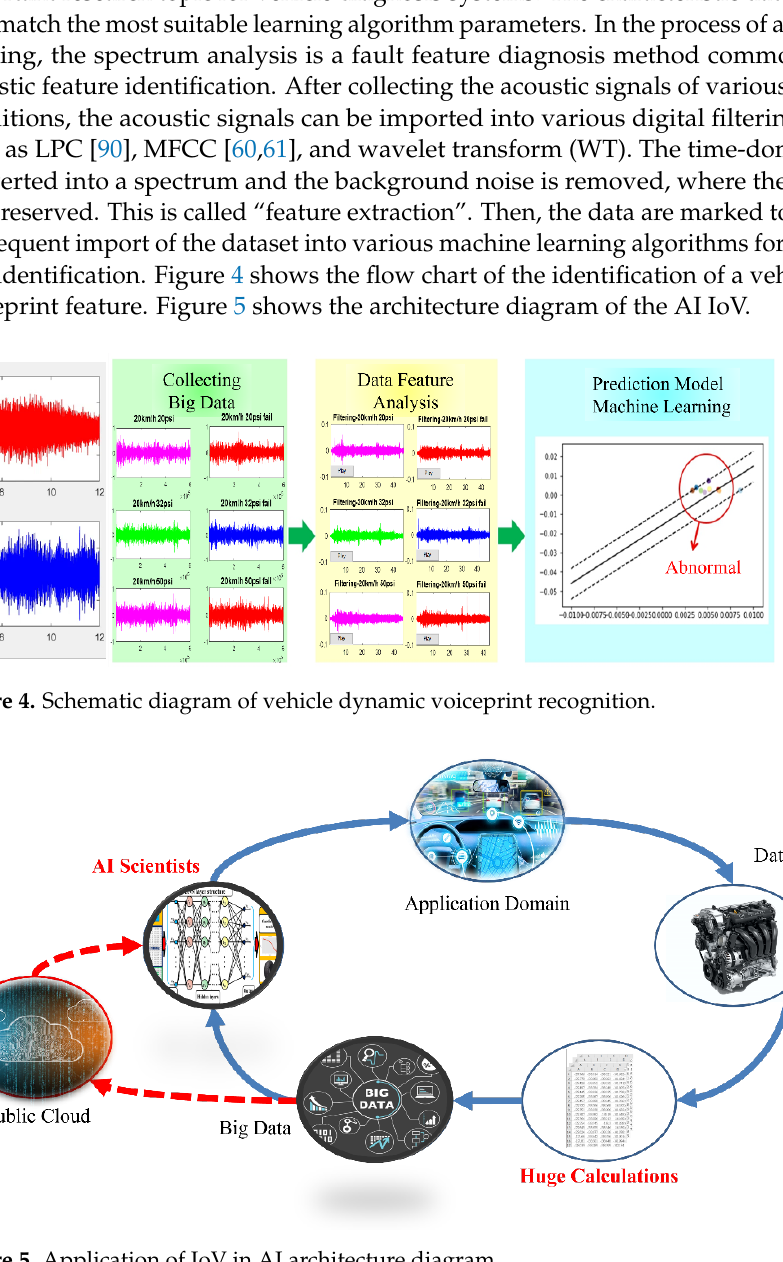
Figure 5. Application of IoV in AI architecture diagram.